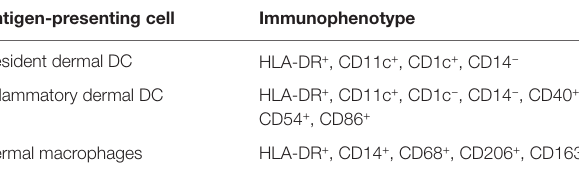
TaBle 1 | Phenotype of different dermal antigen-presenting cells.